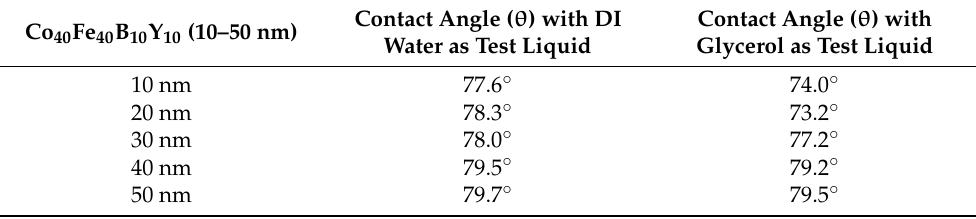
Table 5. Average contact angles of CoFeBY nanofilms after annealing at 200 ◦ C with DI water and glycerol.